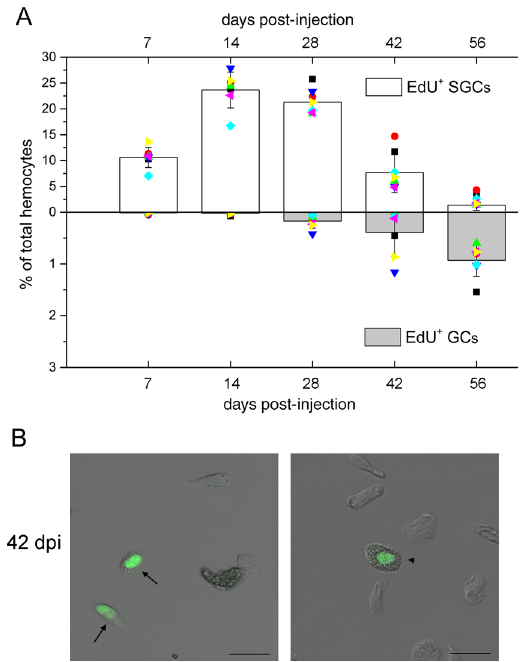
Figure 2. New hemocytes belonging to the GC lineage take approximately one month to mature. Crayfish were injected with one dose of EdU. Hemolymph was taken at different time intervals until 56 dpi for analysis. The percentages of EdU-incorporated (EdU + , green) GCs and SGCs in the total hemocytes were determined by flow cytometry and recorded until 56 dpi ( A ). Eight animals were used in each group. For each sample, over 10,000 cells were analyzed. Data from different individuals are indicated by different symbols. Images of EdU-incorporated hemocytes at 42 dpi are shown ( B ). EdU-incorporated SGCs are indicated with arrows, and EdU-incorporated GCs are indicated with arrowheads. Bar, 25